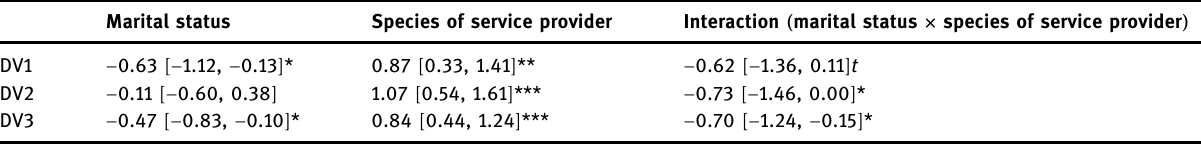
Table 2: Results of the main